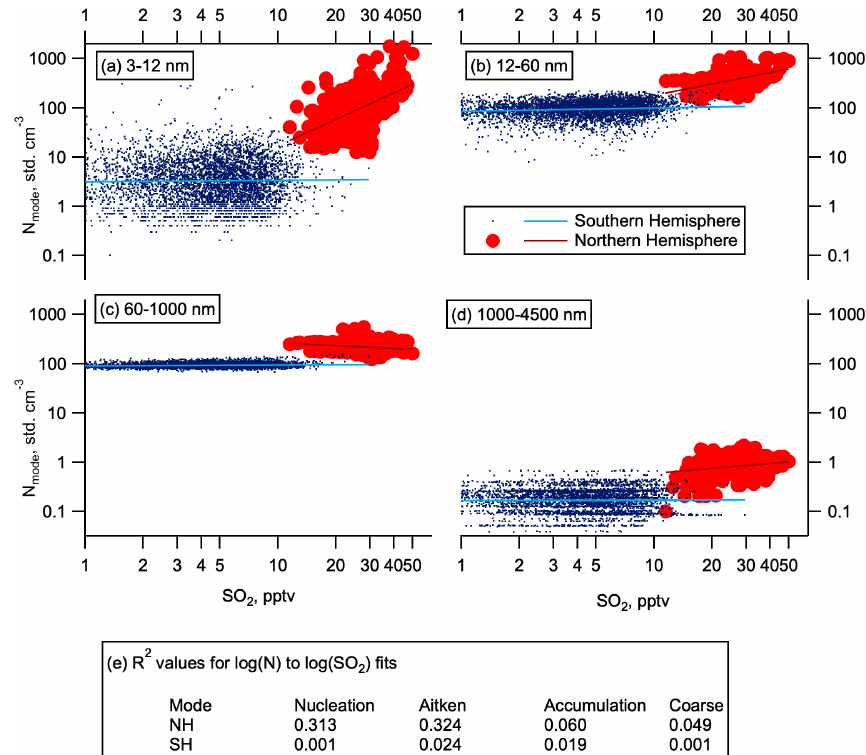
Figure 6. Aerosol correlations with SO 2 . Number concentration dependence on SO 2 at 0.1Hz time resolution to reduce the effect of at- mospheric and instrumental noise following Williamson et al. (2019). Number concentration as a function of SO 2 mixing ratios in May (high-resolution SO 2 data were not available in other seasons) for the Northern Hemisphere and Southern Hemisphere (red circles and blue dots respectively). Data are divided into four modes by size: (a) nucleation (3–12nm), (b) Aitken (12–60nm), (c) accumulation (60– 1000nm), and (d) coarse (1000–4500). Log–log fits are given by the solid lines. Panel (e) shows R 2 values for these fits. Observations where SO 2 is below the limit of detection (1pptv) are not